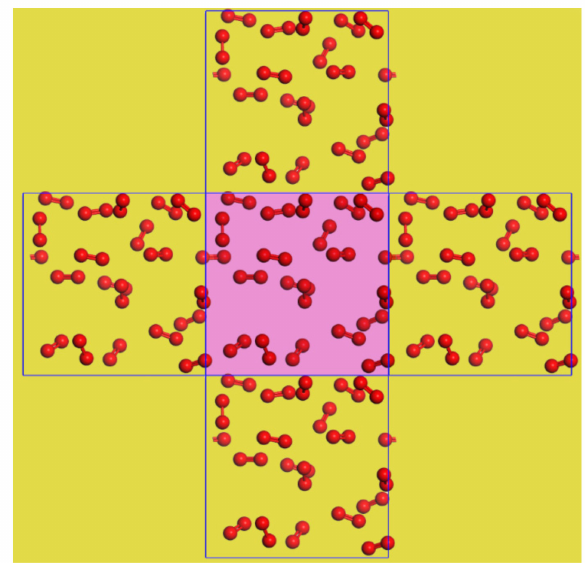
Figure 6. Schematic diagram of the periodic boundary of a planar system, with the simulated system in the center and the boundary enclosing its translated